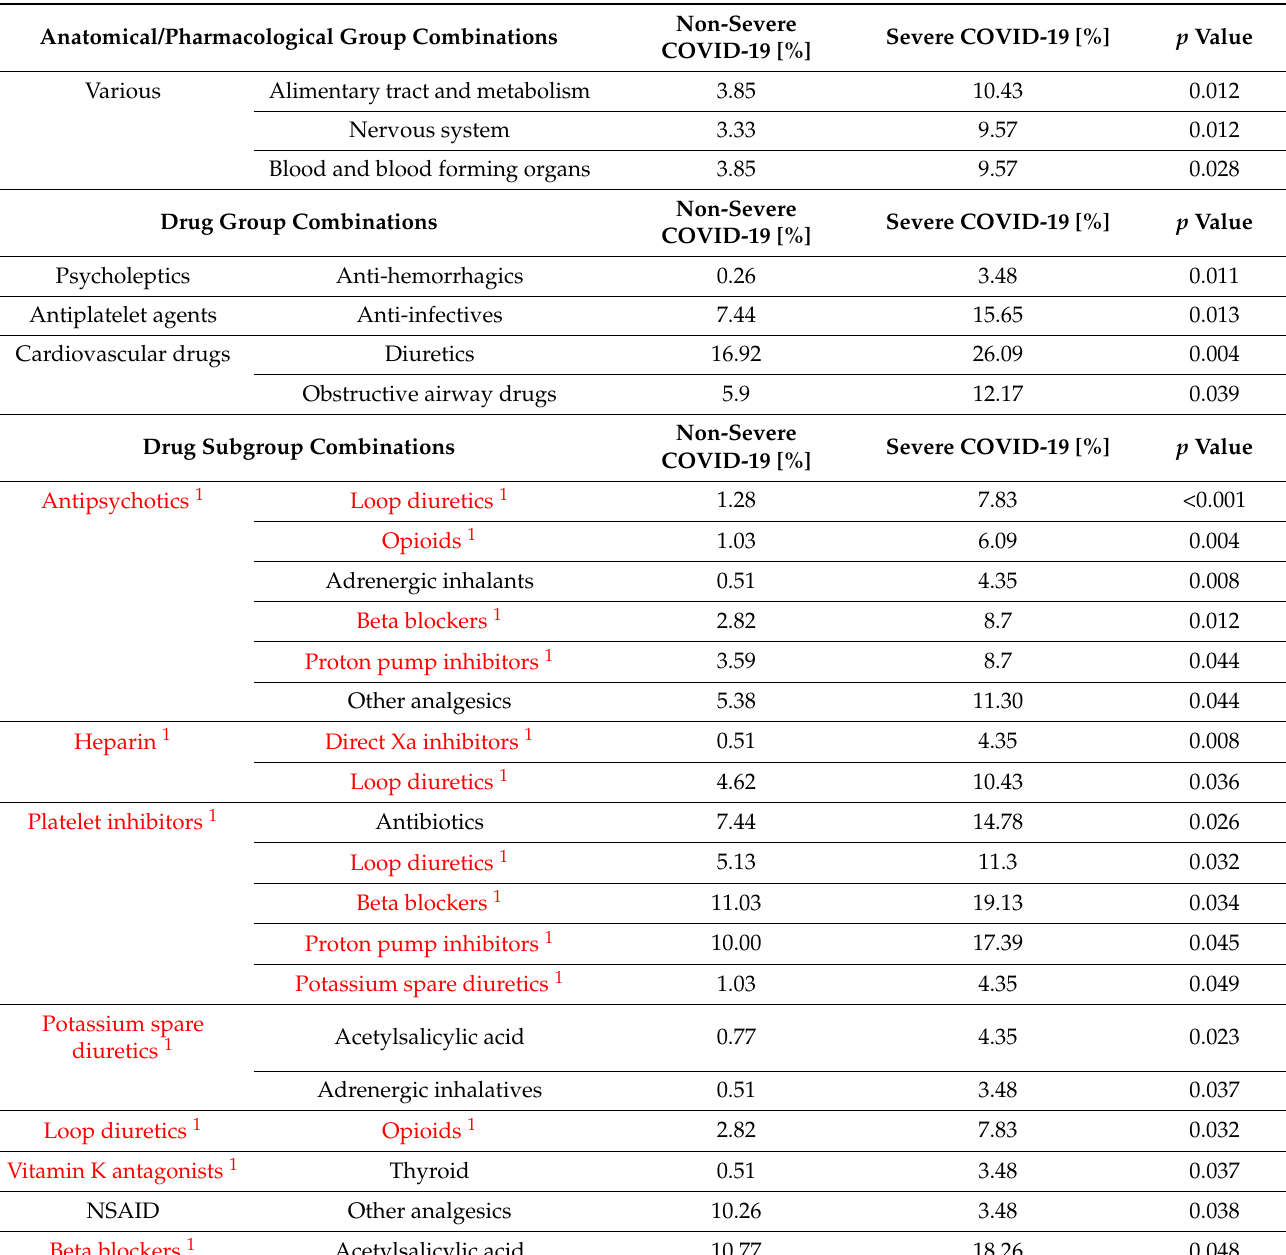
Table 3. Significant edges of the DDSI